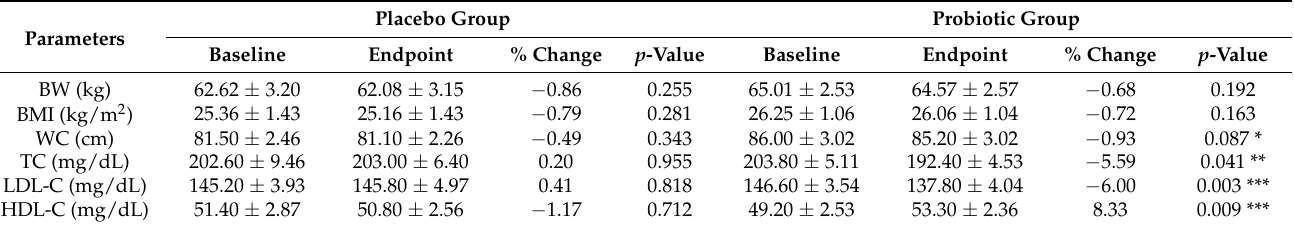
Table 4. Physical examination parameters and biological markers in plasma and feces of the partici- pant at the baseline (Day 0) and endpoint (Day